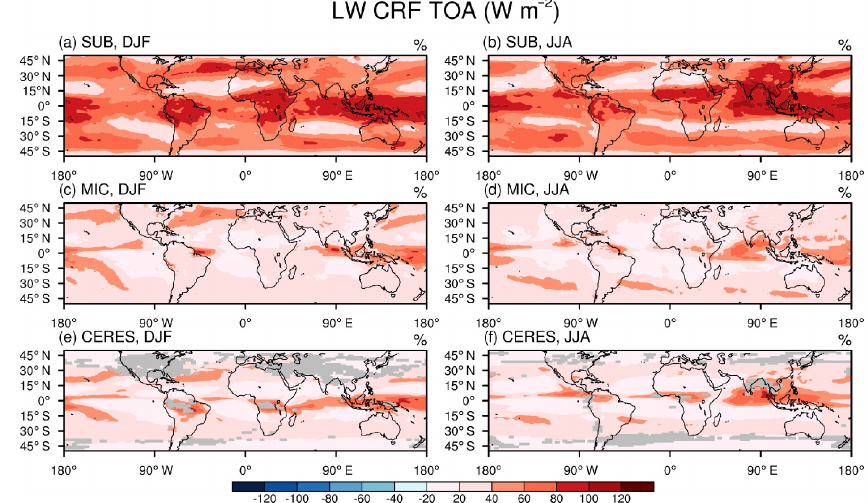
Figure 6. Simulated 10-year mean TOA LW radiation budget for DJF (left panels) and JJA (right panels) by SUB and MIC and CERES observations. Grey areas indicate missing values.